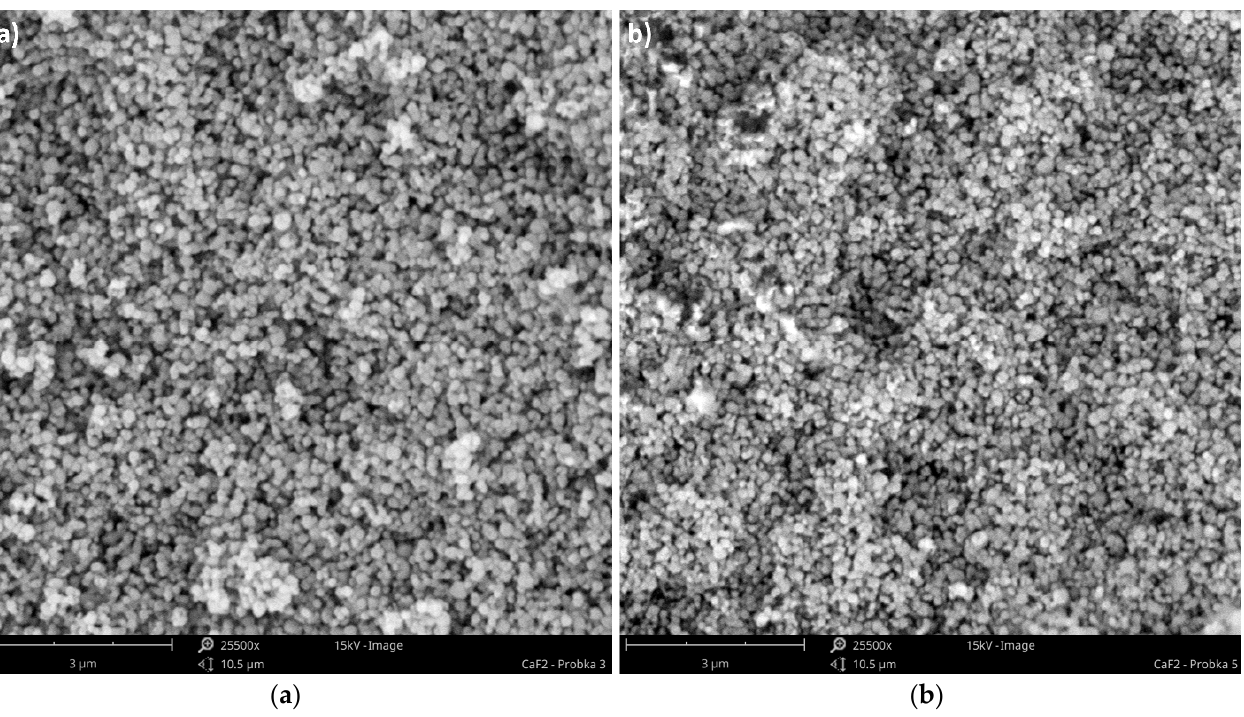
Figure 8. The shape of CaF 2 particles precipitated in the Koflo STM—SEM images. Magnification 20,000×, size bare: 3 μ m; ( a ) silent conditions Re eqv = 1091; ( b ) US-assisted system Re eqv = 6623.